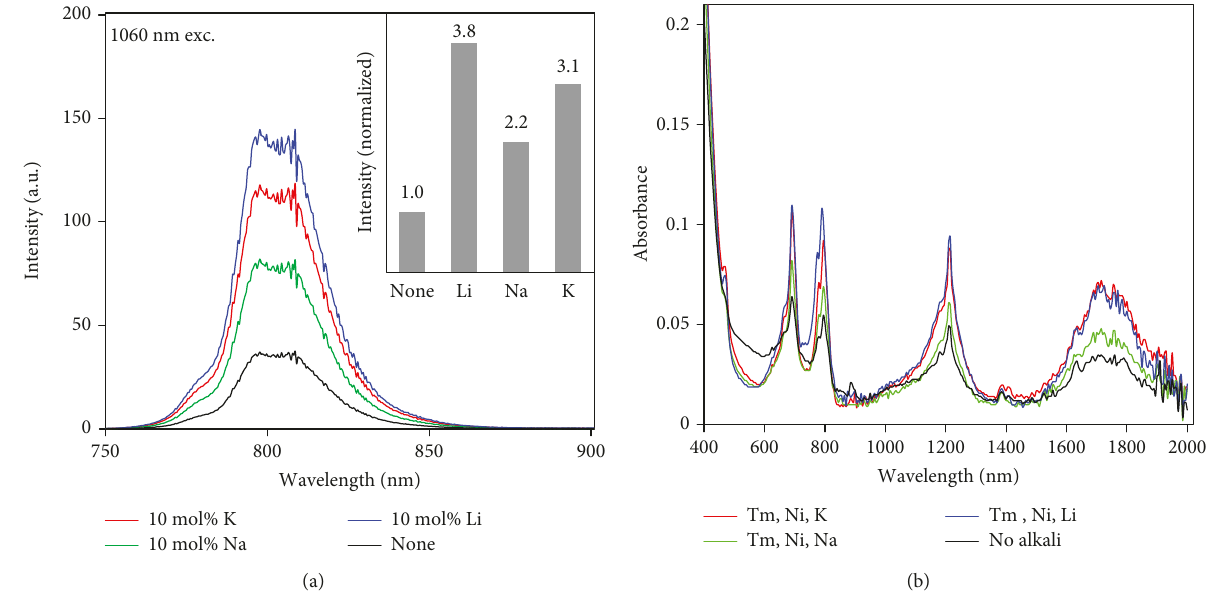
Figure 7: (a) UC emission and (b) absorption spectra of the CaTi normalized UC emission intensities integrated over 760 – 860 nm for various alkali ions